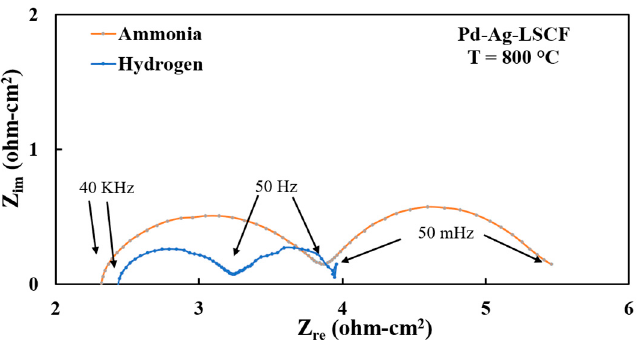
Figure 12. Schematic of the proposed anode reaction mechanism showing the hydrogen absorption and shift of ammonia cracking reaction towards the right.